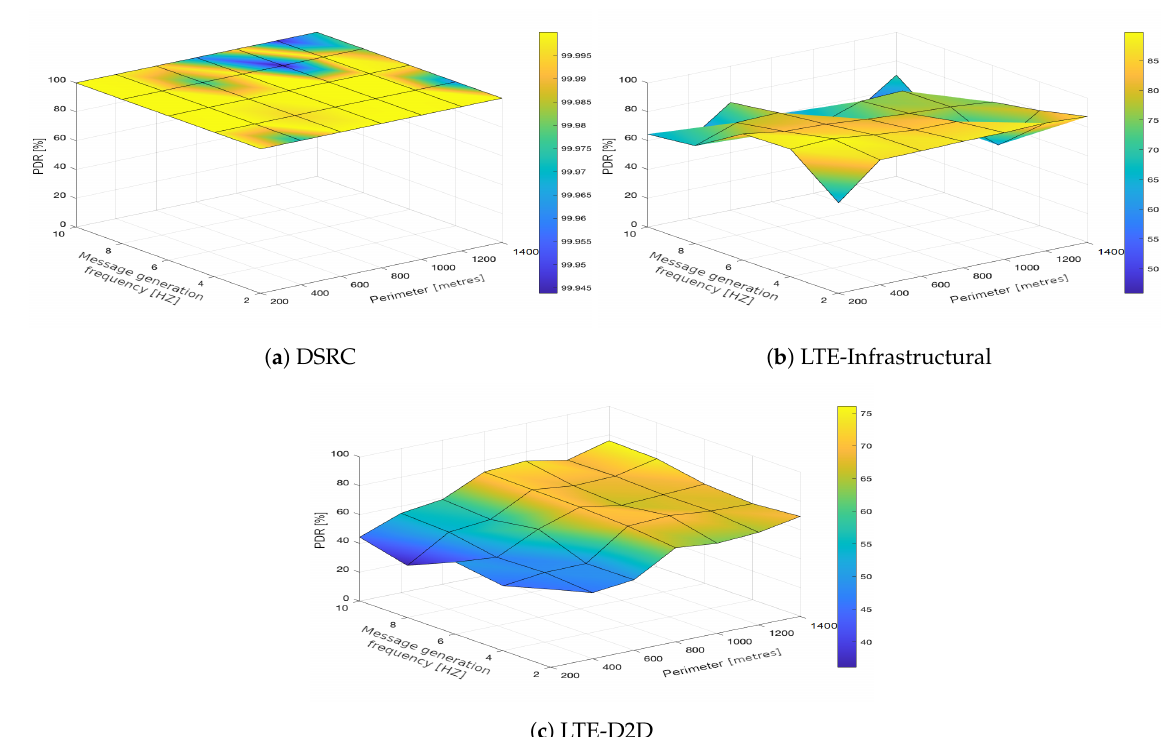
Figure 4. Packet delivery ratio obtained for the traffic intensity of 750 vehicles per hour.